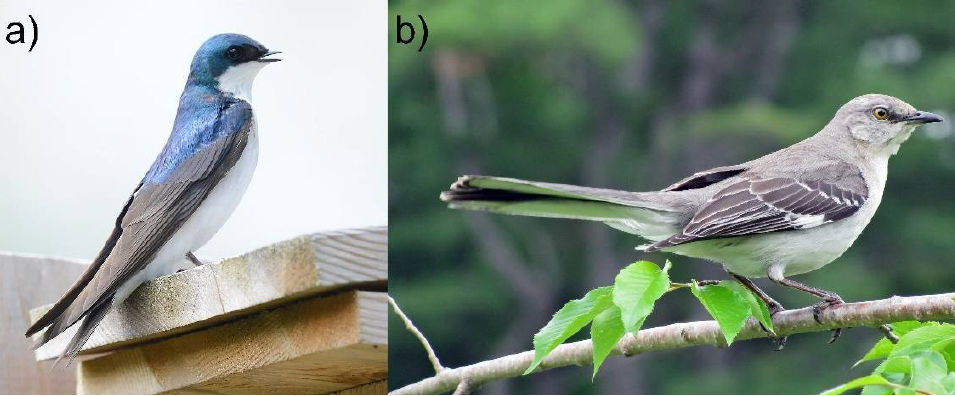
Figure 4. The most ( a ) and least ( b ) preferred songbird species, ranked according to their traits. ( a )